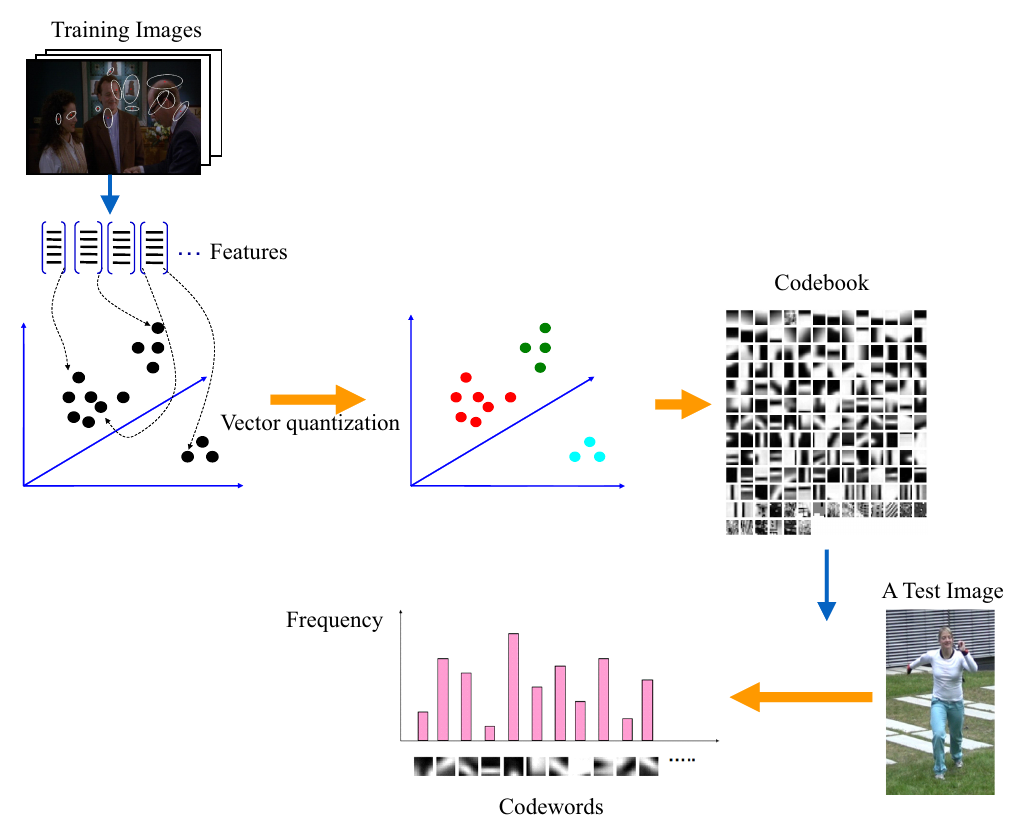
Figure 12. Bag-of-words feature representation